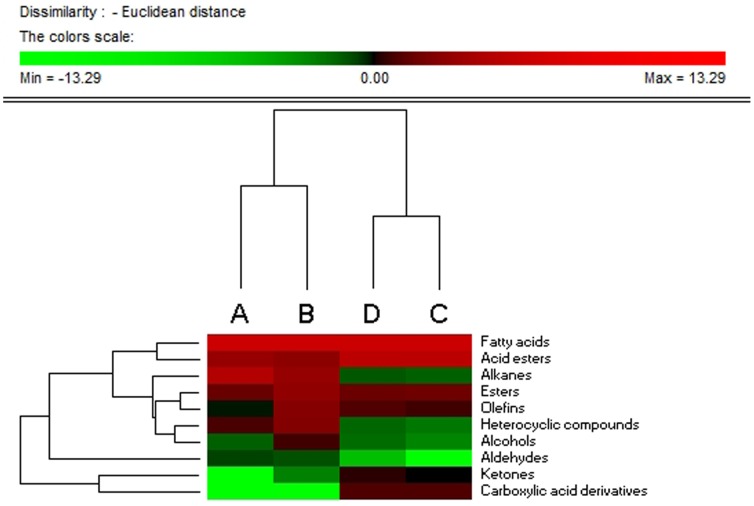
Hierarchical analysis of the total content of different groups in volatile oil in four kinds of materials.A, B, C and D represent the seeds, fruit, suspension cell and callus. Colors in the heatmap mean the fold change in according to the above, red and green represent the higher and lower levels, respectively.